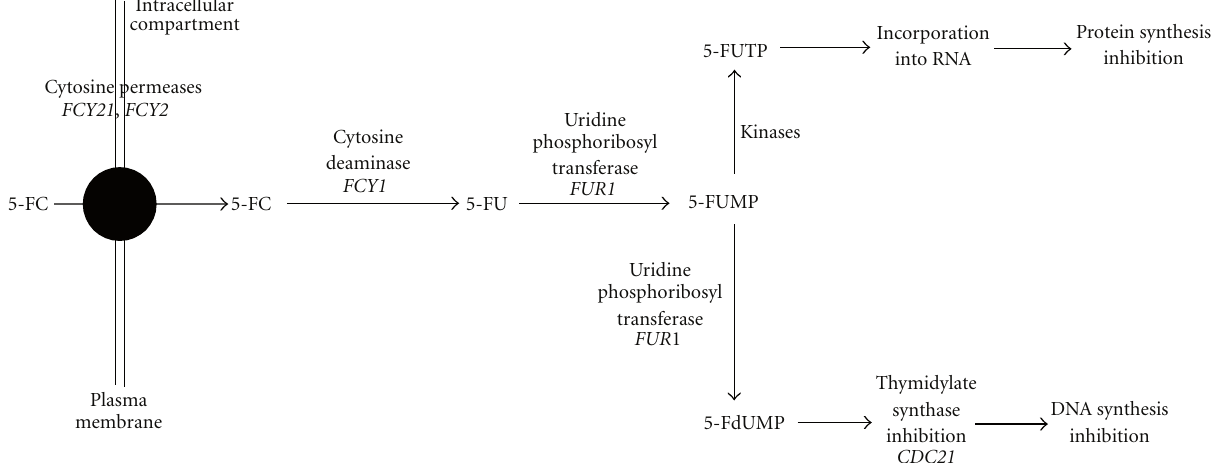
Figure 2: Intracellular metabolization and action mode of 5-FC in S. cerevisiae , adapted from [11]. In bold are indicated gene names of the respective enzymes. 5-FC: 5-fluorocytosine; 5-FU: 5-fluorouracil; 5-FUMP: 5-fluorouridine monophosphate; 5-FUTP: 5-fluorouridine triphosphate; 5-FdUMP: 5-fluoro deoxyribouridine monophosphate.